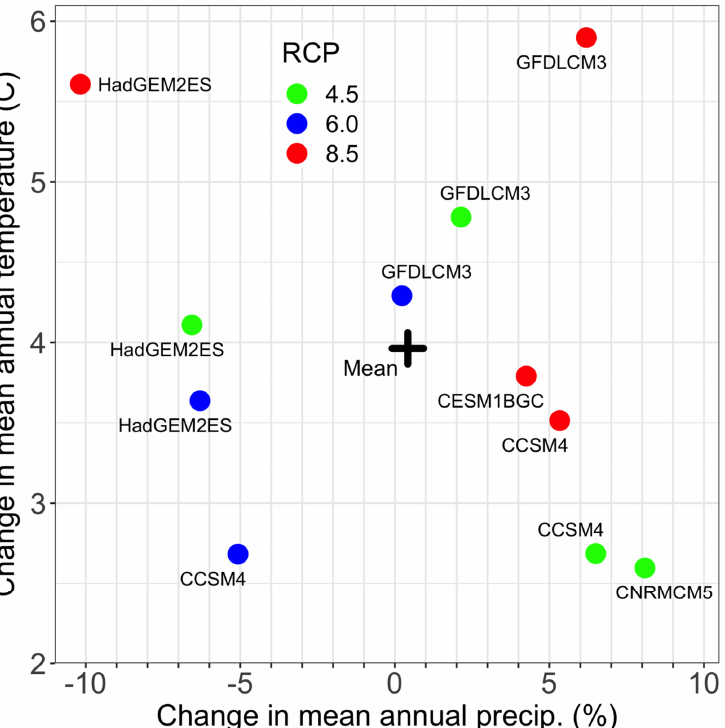
Figure 2. Changes in mean annual temperature and precipitation in the study area between the reference period and the decade around 2060, as projected by the 11 climate scenarios. The mean of all scenarios is represented by “+”.